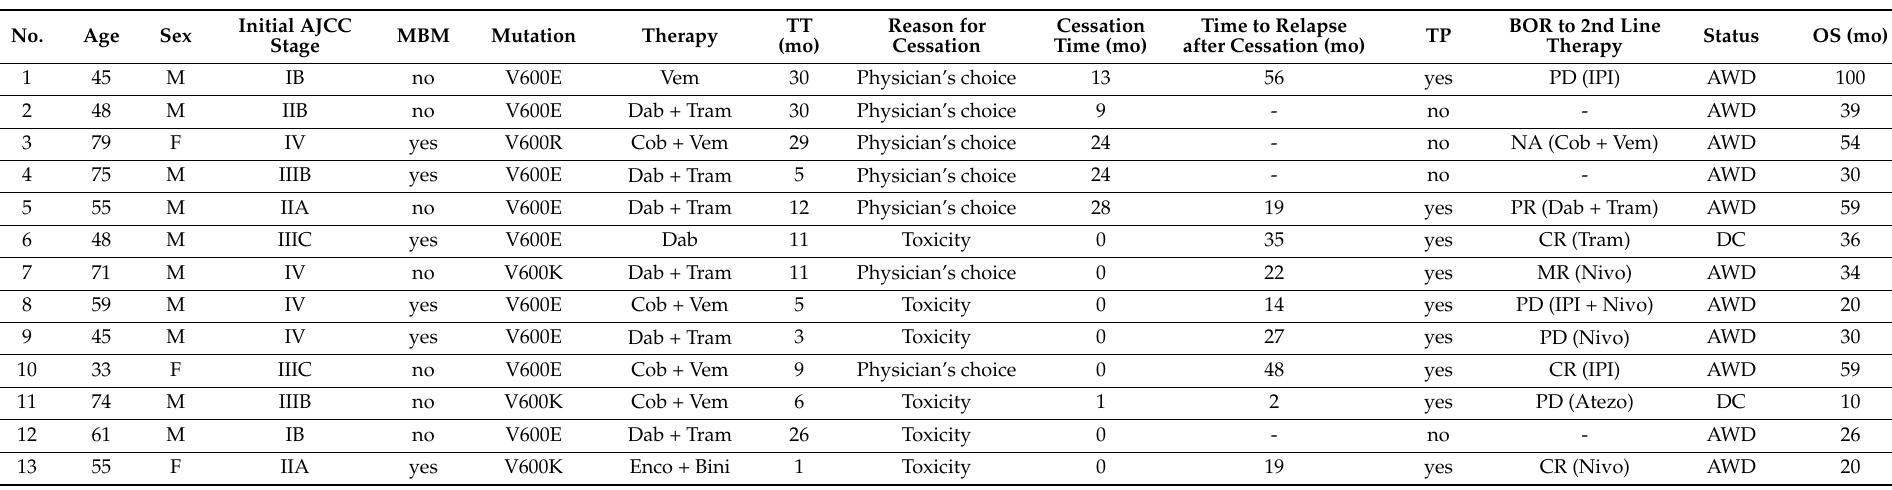
Table 2. Patient characteristics in a subcohort of patients who discontinued TT due to reasons other than